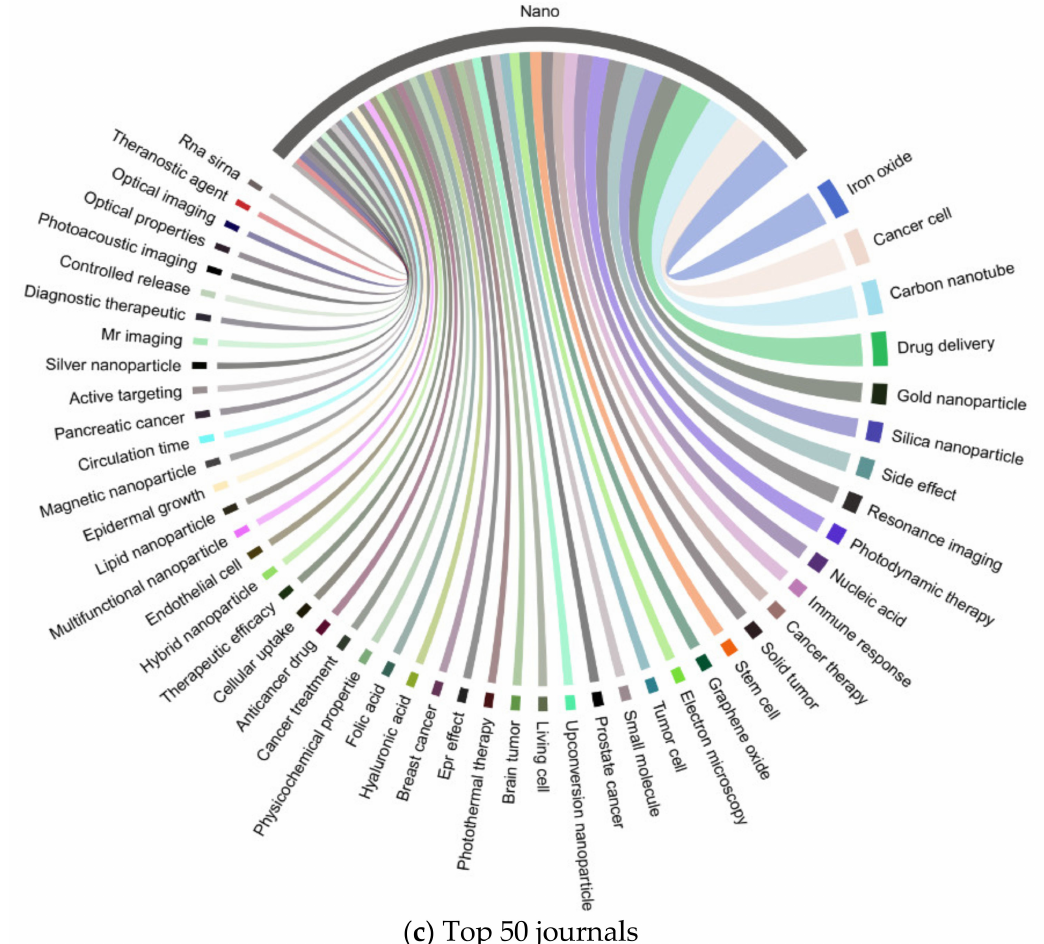
Figure 9. Chord diagram of research areas in nanotechnology for the three scenarios: ( a ) entire dataset, ( b ) top 100 journals, and ( c ) top 50 journals. The chord diagram was produced using the circlize package in R based on the adjacency matrix of keywords associated with nanotechnology. For better image quality, readers are encouraged to check the URL: https://1data.life/pages/publication/Cancer%20Nanotechnology.html (accessed on 20 August